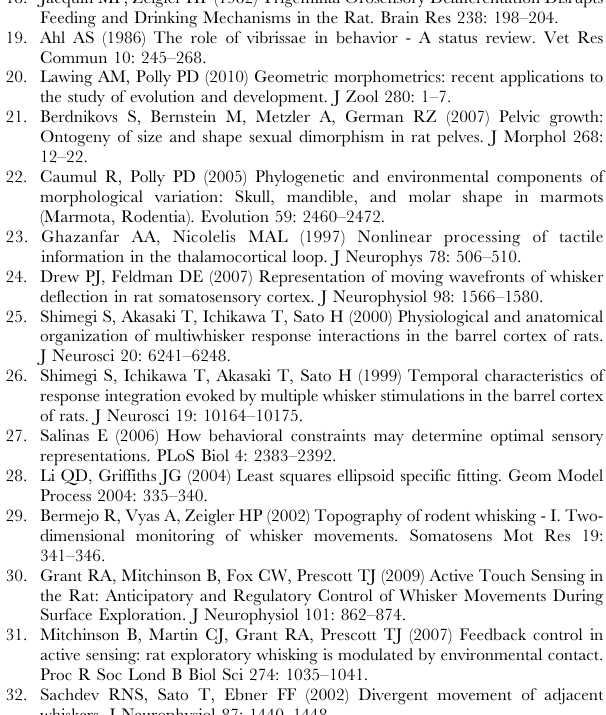
Figure S1 Cesa`ro linear fit coefficients to the whisker 2D shape. (A) The general shape of any given whisker can be inferred from the coefficients of its fit to the equation k (s)= A s + B . Abbreviations (in red) describe how the curvature changes from base to tip along the length of a whisker for special regions of the coefficient space, and are defined in the table of abbreviations (Table S1). A graphical example of each type of curvature is provided in the plot. Diagonal dotted lines indicate A = 2 B and A = B . (B) Coefficients A versus B for whiskers of normalized arc length. The best fit linear approximation is shown in dark gray along with the corresponding equation. The two coefficient coefficients were highly correlated (correlation coefficient r= 2 0.867), with a statistically significant relationship (p , 0.001). Gray line depicts this linear fit. The dashed lines represent A = 2 B and A = B . Asterisk indicates one outlier data point that was outside the plot boundaries.